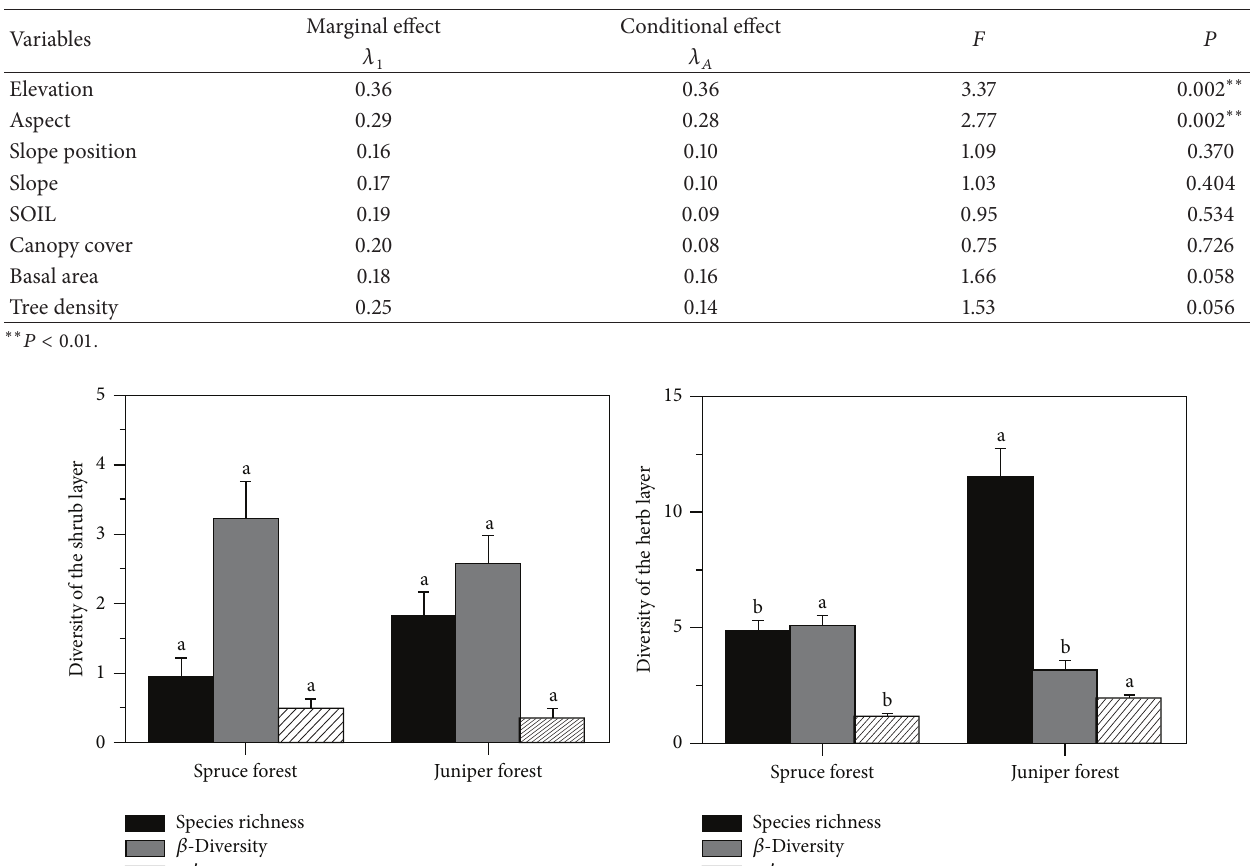
Table 4: Marginal and conditional effects of each environmental variable obtained from the forward selection in the CCA ordination.